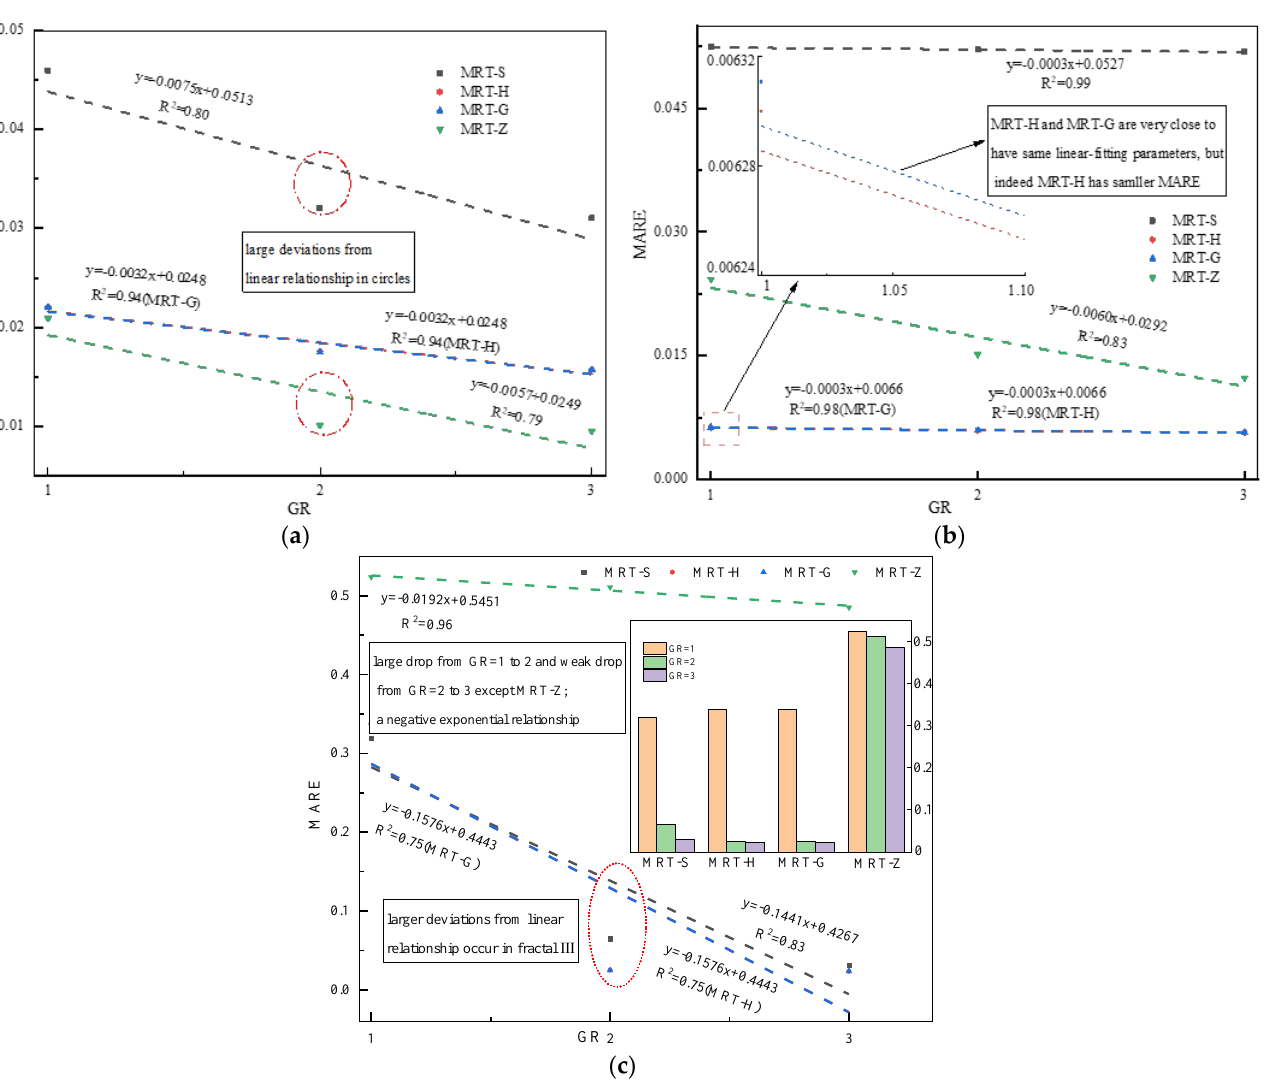
Figure 9. ( a ) MARE vary with different GRs in fractal I. ( b ) MARE vary with different GRs in fractal II; ( c ) MARE vary with different GRs in fractal III.